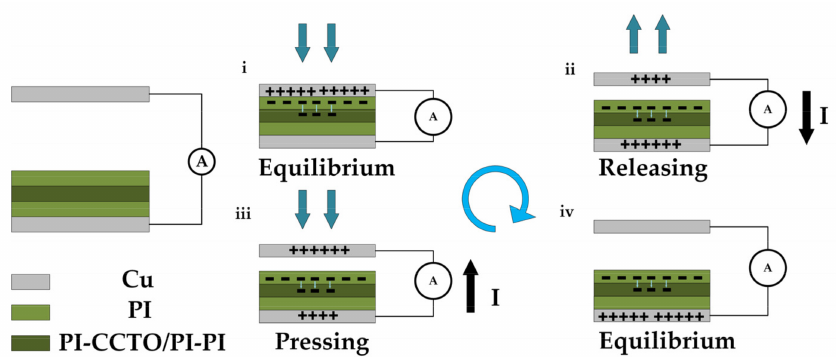
Figure 8. The working mechanism of CS − TENG based on a PI-(CCTO/PI)-PI nanocomposite film. ( i ) initial state. ( ii ) release state. ( iii ) press state. ( iv ) equilibrium